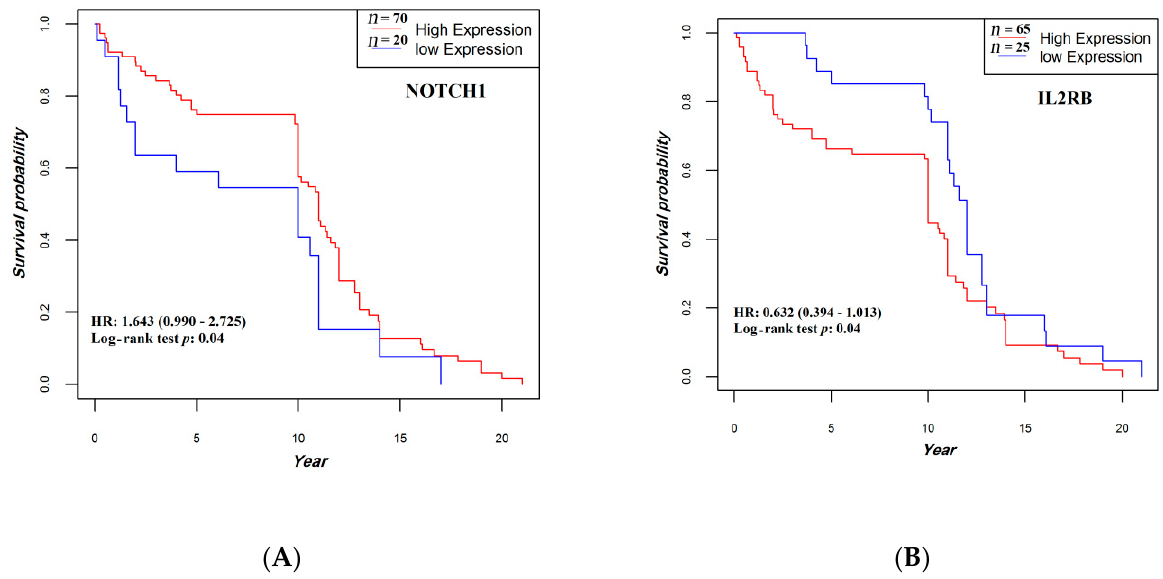
Figure 8. Association between NOTCH1 ( A ) and IL2RB ( B ) expression and overall survival. The median follow-up was 10.8 (0.95LCL–0.95UCL; 10–11) years. HR, hazard ratio.